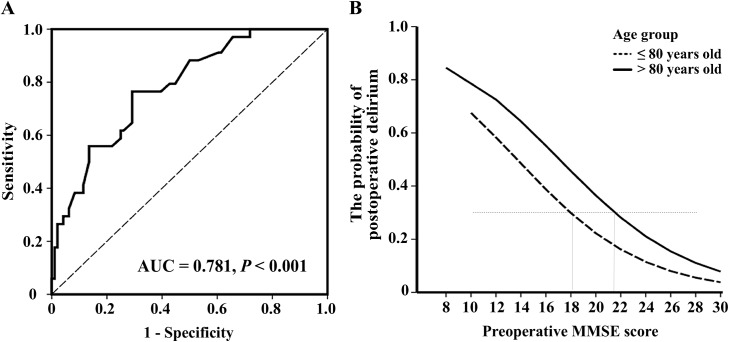
The preoperative MMSE score predicts the postoperative delirium.(A) ROC analysis was used for the determination of the diagnostic sensitivity and the specificity of the preoperative optimum cutoff score of MMSE versus CAM. (B) The relationship of probability of postoperative delirium and the preoperative MMSE score was determined by these formulas: [Logit (p) = 2.714–0.198*MMSE] and [Logit (p) = 3.263–0.191*MMSE] for the young-old and old-old participants, respectively. The probability of the postoperative delirium decreases with the increase of the MMSE scores, with a linear association in both groups of participants, young-old (dotted line) and old-old (solid line).